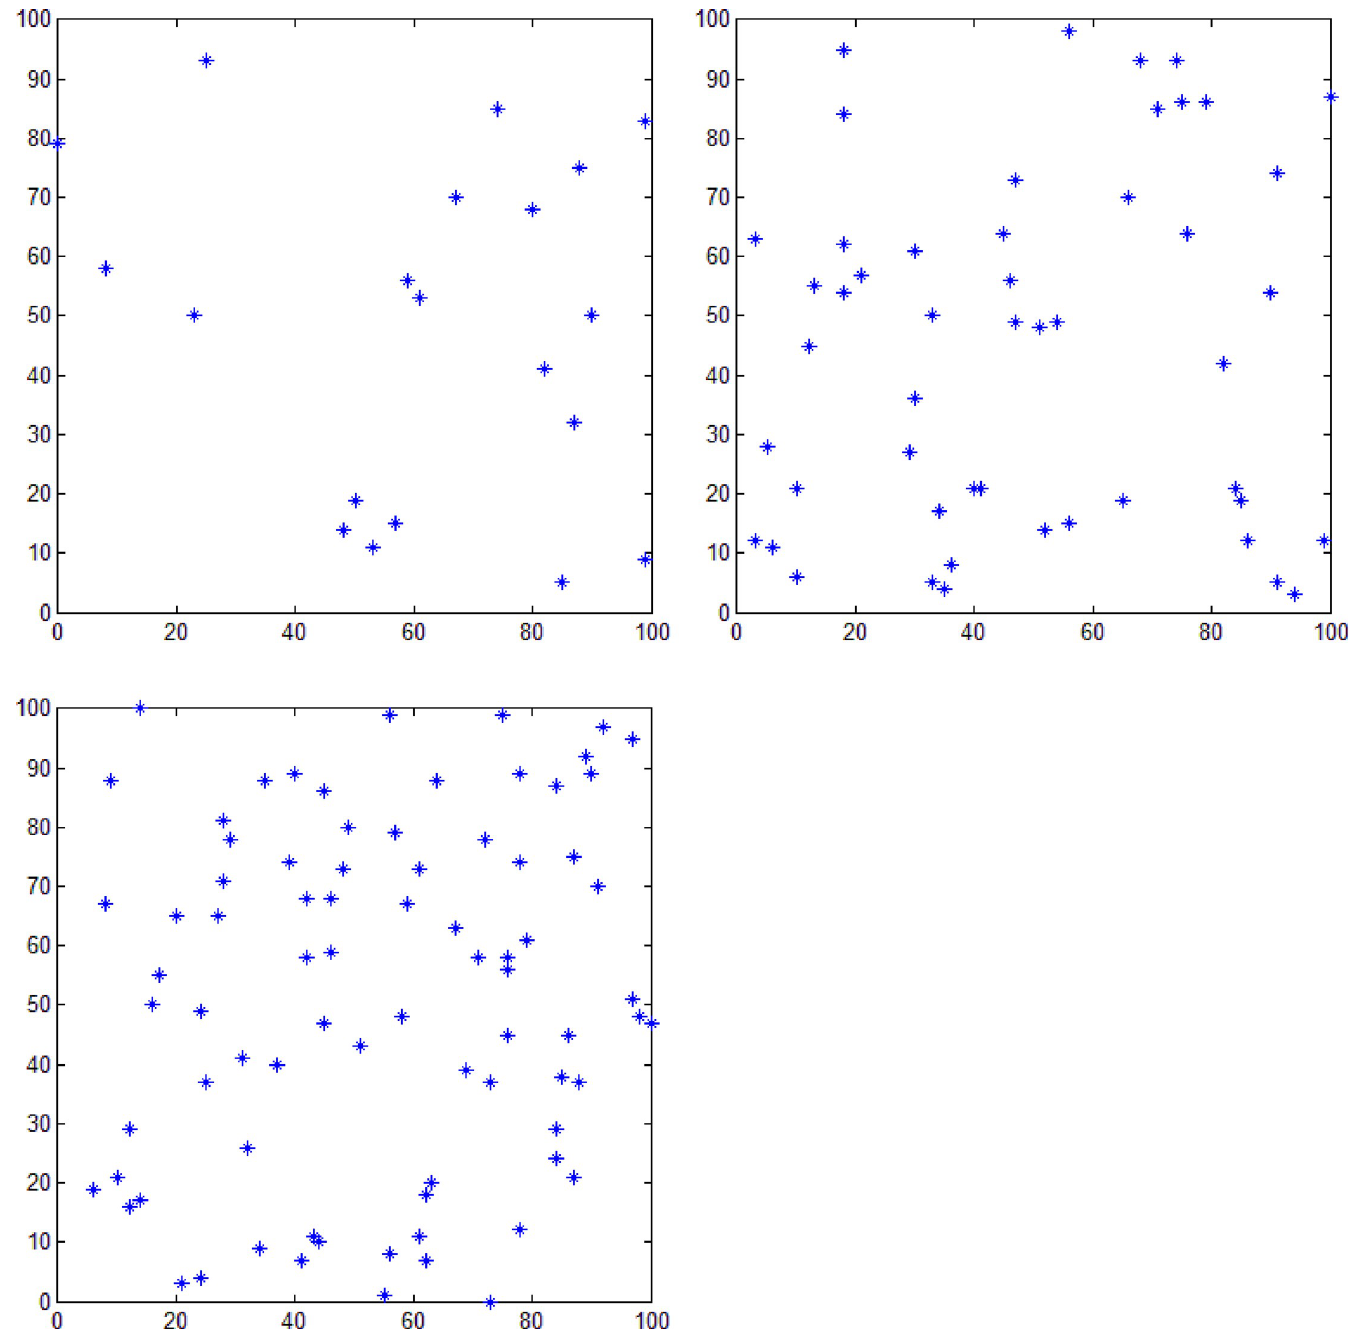
Fig 11. Plane distribution of random points. Plane distribution of (a) 20, (b) 50, and (c) 80 random